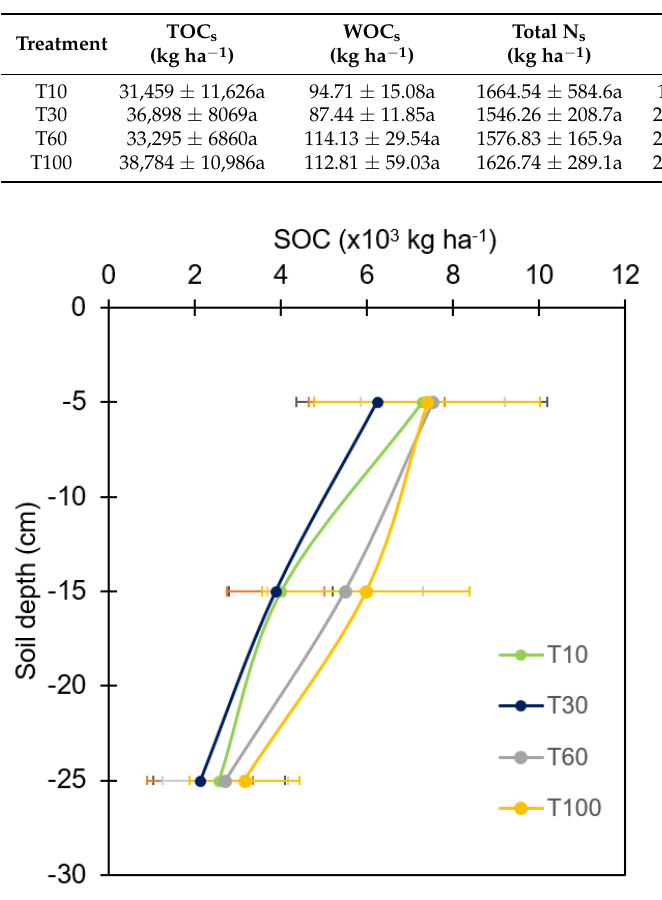
Table 3. Mean ± standard deviation soil values for total organic carbon (TOC s ), soluble organic carbon (WOC s ), total N s , C/N s relationship, and basal respiration after 28 days of incubation (BR s ). Lower case letters denote significant differences (Tukey’s HSD/Tamhane’s T2 post hoc tests) for the factor thinning treatment at p -value < 0.05.